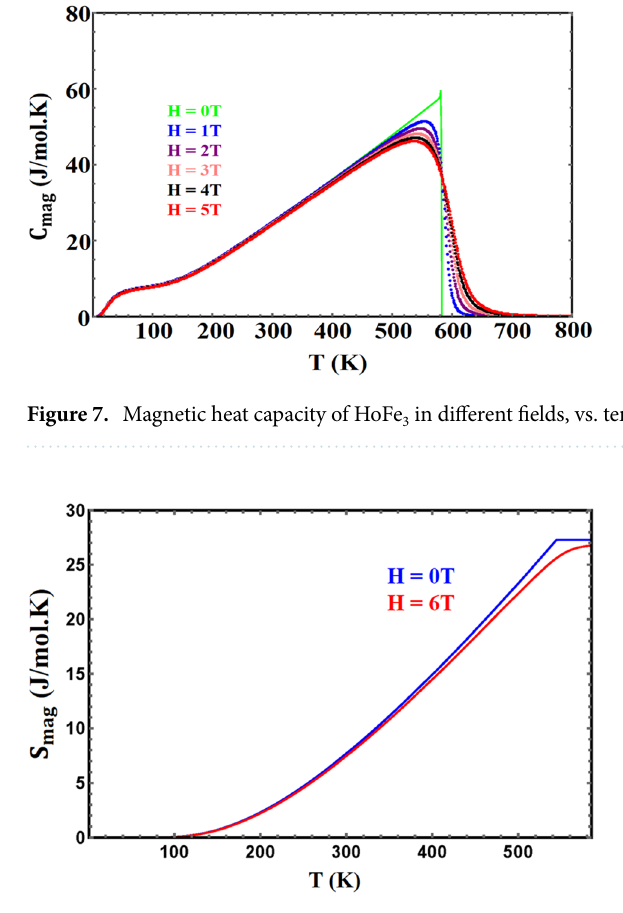
Figure 8. The calculated magnetic entropy of YFe 3 in two different fields vs.